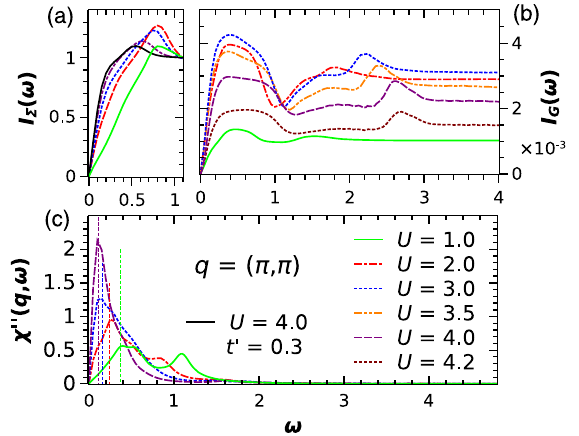
ð ω Þ , and (c) the G